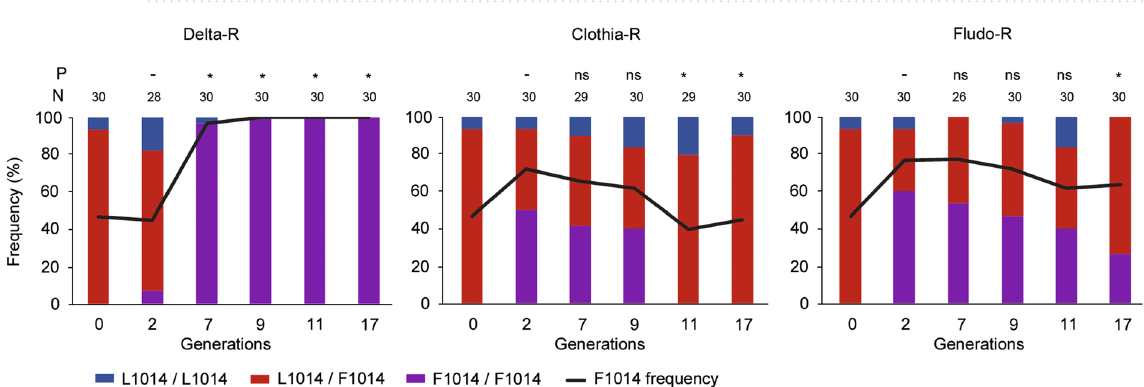
Figure 3. Dynamics of the L1014F kdr mutation along the selection process. For each line, the L1014F kdr mutation was genotyped in individual mosquitoes using the allele-specific qPCR TaqMan assay described in Bass et al. 66 . For each selected line, both genotype and allele frequencies are reported. N number of individuals genotyped. P significance of genotype frequencies changes as compared to generation G2 (Chi 2 test, ns non- significant, *P <